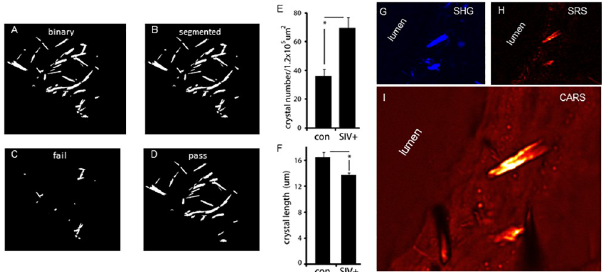
Fig 3. Counts of CCs number and length by Otsu’s method. (A) binary rendering of the SHG control plaque image shown in Fig 2A–2C, (B) after segmentation, (C) failed overlapping objects (D) passed independent objects. (E) Graph of CC number per unit area of control and SIV + plaques, (F) Graph of CC length of control and SIV + plaques. For E & F a total of 973 objects were counted from 5 animals (con-2, Siv + -3, 3–4 images/animal, p value < 0.05 for E, and < 0.0001 for F, by paired t- test). (G-I) A SIV+ plaque showing CCs in the luminal endothelial layer using SHG (G), SRS (H), and CARS (I).